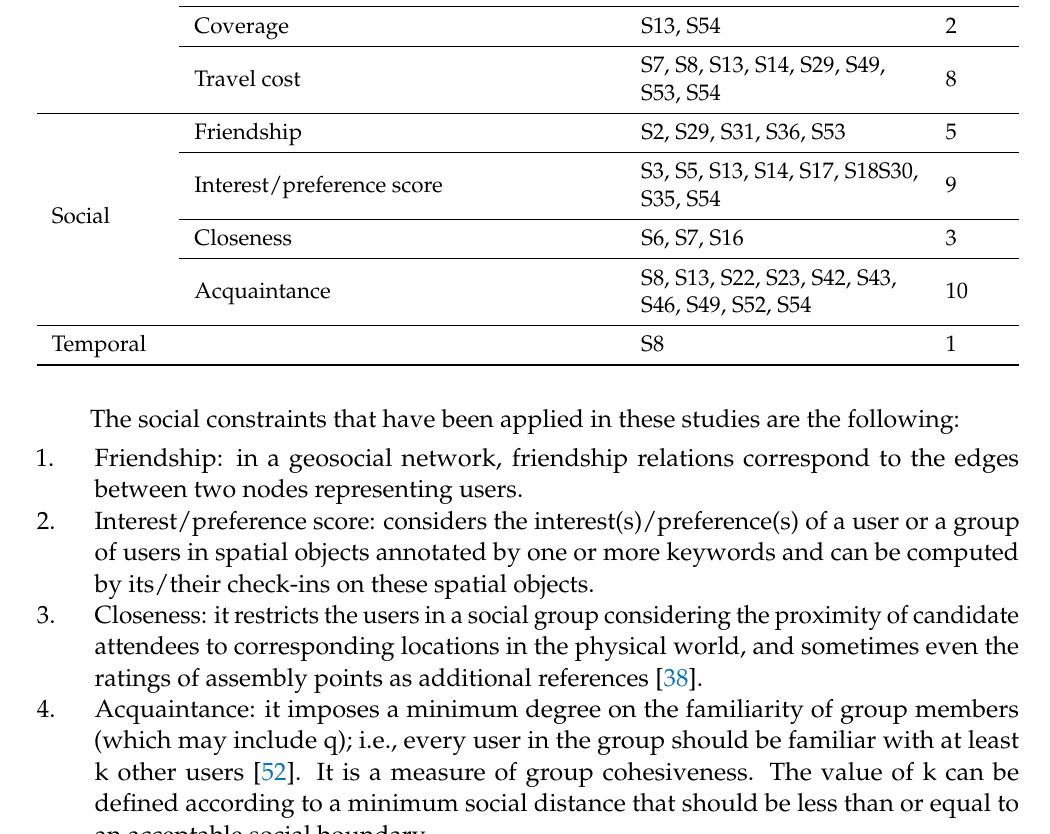
Table 7. Main types of spatial, social, and temporal constraints applied in geosocial group queries. Constraints Paper ID Total